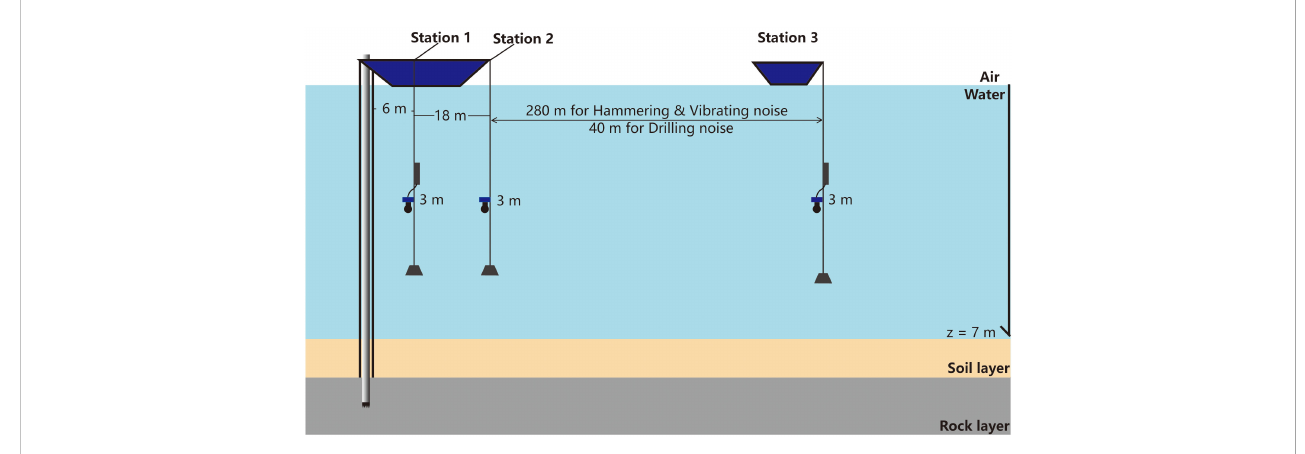
FIGURE 2 Schematic diagram of the measurement con fi guration for underwater noises during OED (distances shown are not to